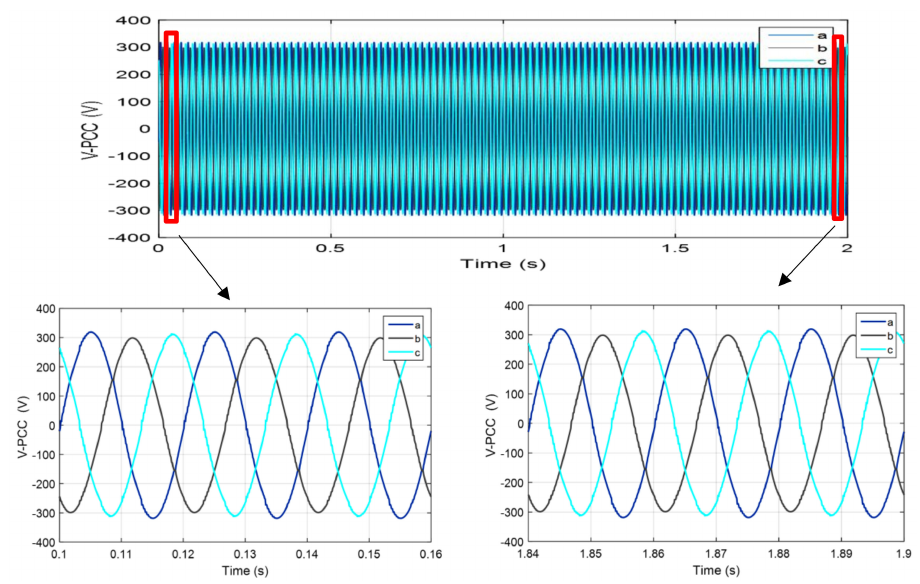
Figure 9. Three-phase voltages at PCC before